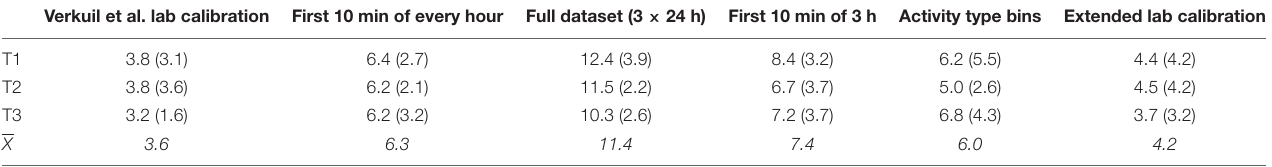
TABLE 2 | Mean number of additional HRV episodes (SD) identified in three test day of 24 h